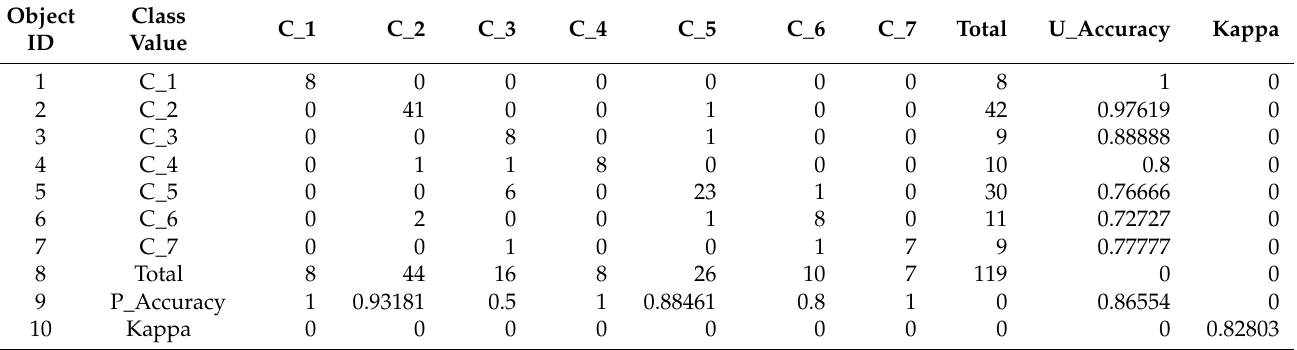
Table 2. Confusion Matrix (ML method).